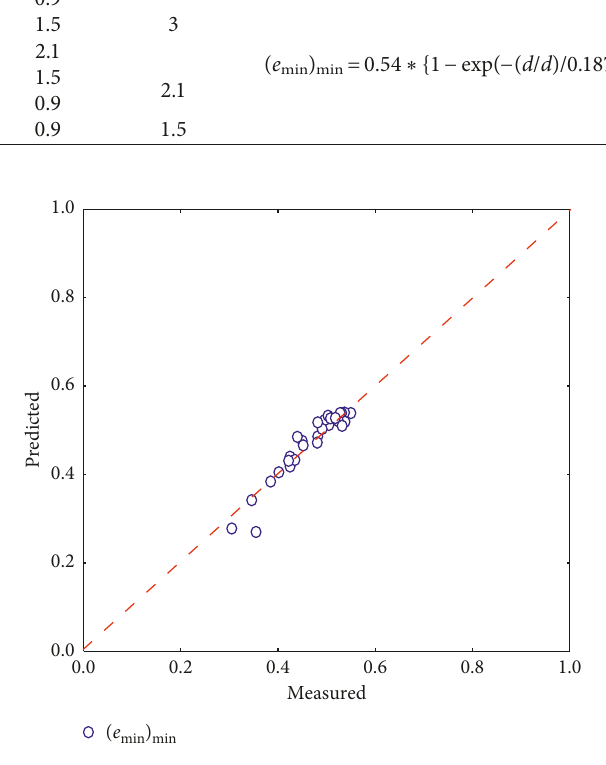
min ) min using equation (2).